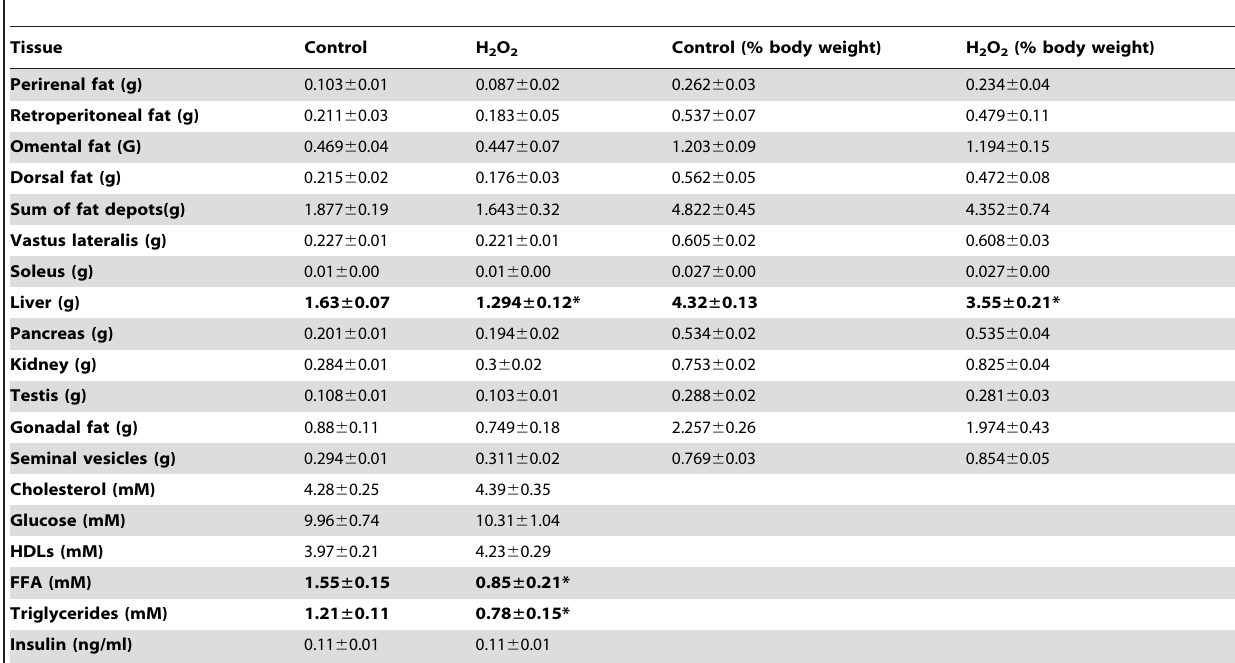
Table 4. Post mortem male offspring body composition and fasting blood metabolites sired by control sperm or sperm treated with 1500 m M H 2 O 2 at 17 weeks of